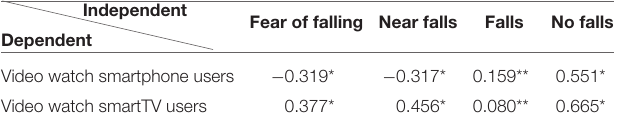
TABLE 8 | Statistical analysis between the two groups using t -test (R s ). DependentIndependent Fear of falling Near